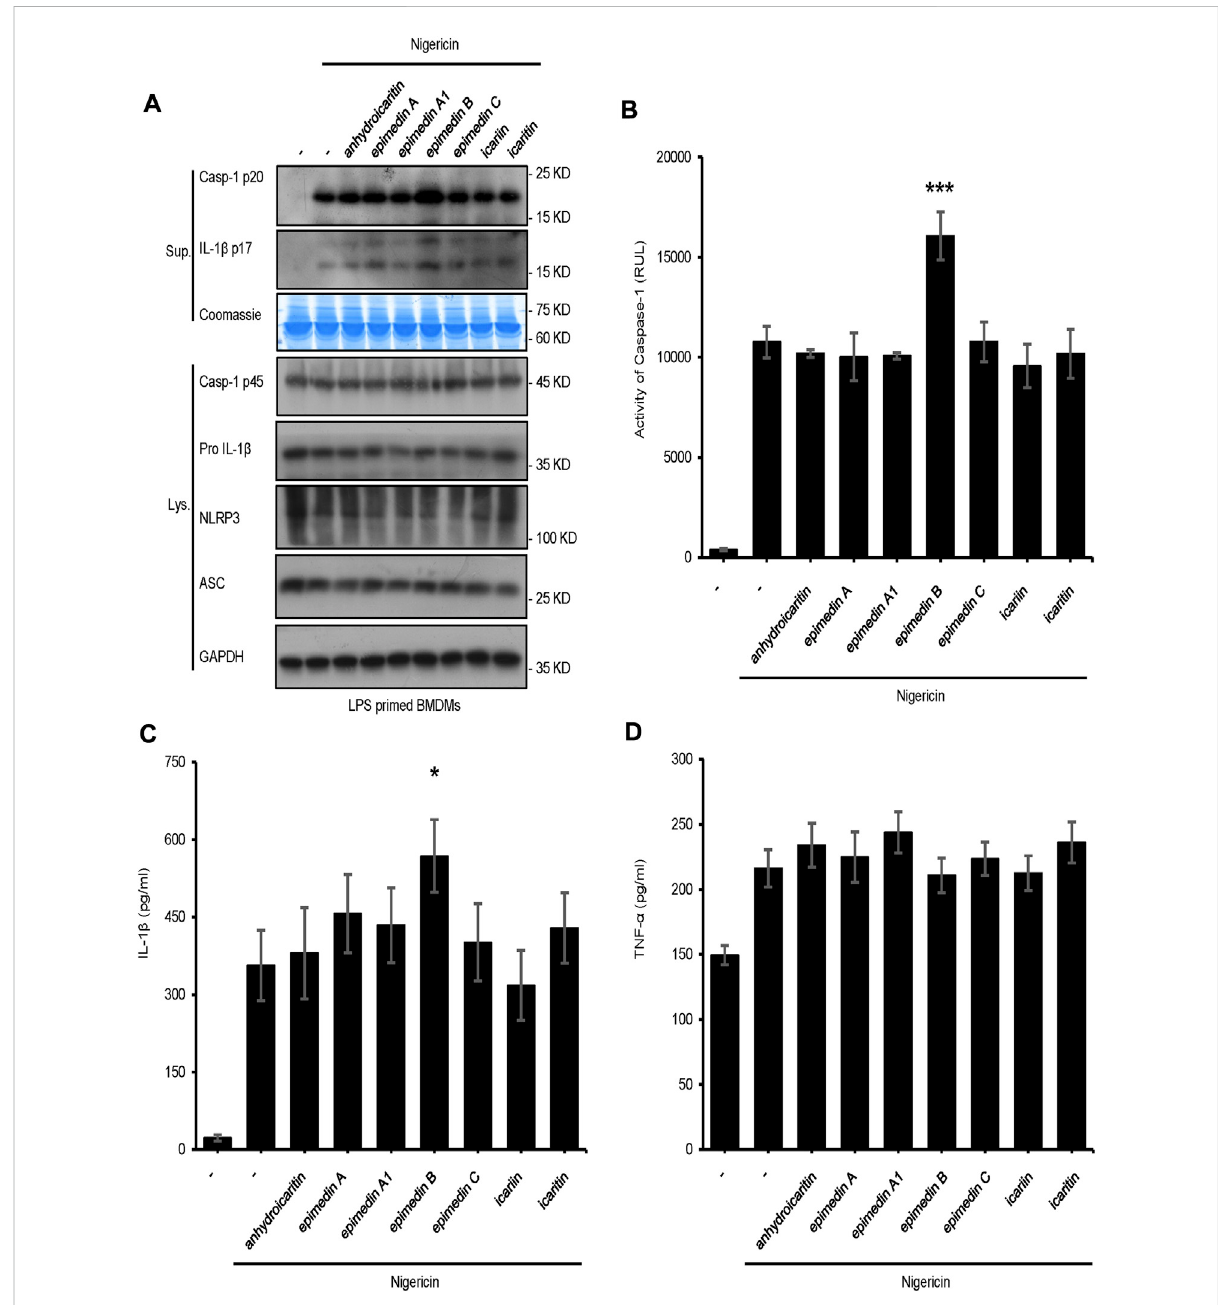
FIGURE 1 Effect of the main constituents of Epimedii folium on NLRP3 in fl ammasome activation. (A) Western blot analysis of supernatants (Sup) and whole-celllysates(Lys)derivedfromlipopolysaccharide(LPS)-primedbonemarrow-derivedmacrophages(BMDMs)subjectedtotreatmentwiththe main constituents of EF (40 μ M) and stimulated with nigericin (10 μ mol/L). (B – D) Caspase-1 activity (B) ELISA of IL-1 β (C) , and TNF- α (D) in Sup derived from the samples described in (A) . Data are expressed as the mean ± SD from at least three biological samples. The signi fi cance of the differences was analyzed using unpaired Student ’ s t -test: * p < 0.05, ** p < 0.01, *** p < 0.001, NS; not signi fi cant, RLUs; relative light